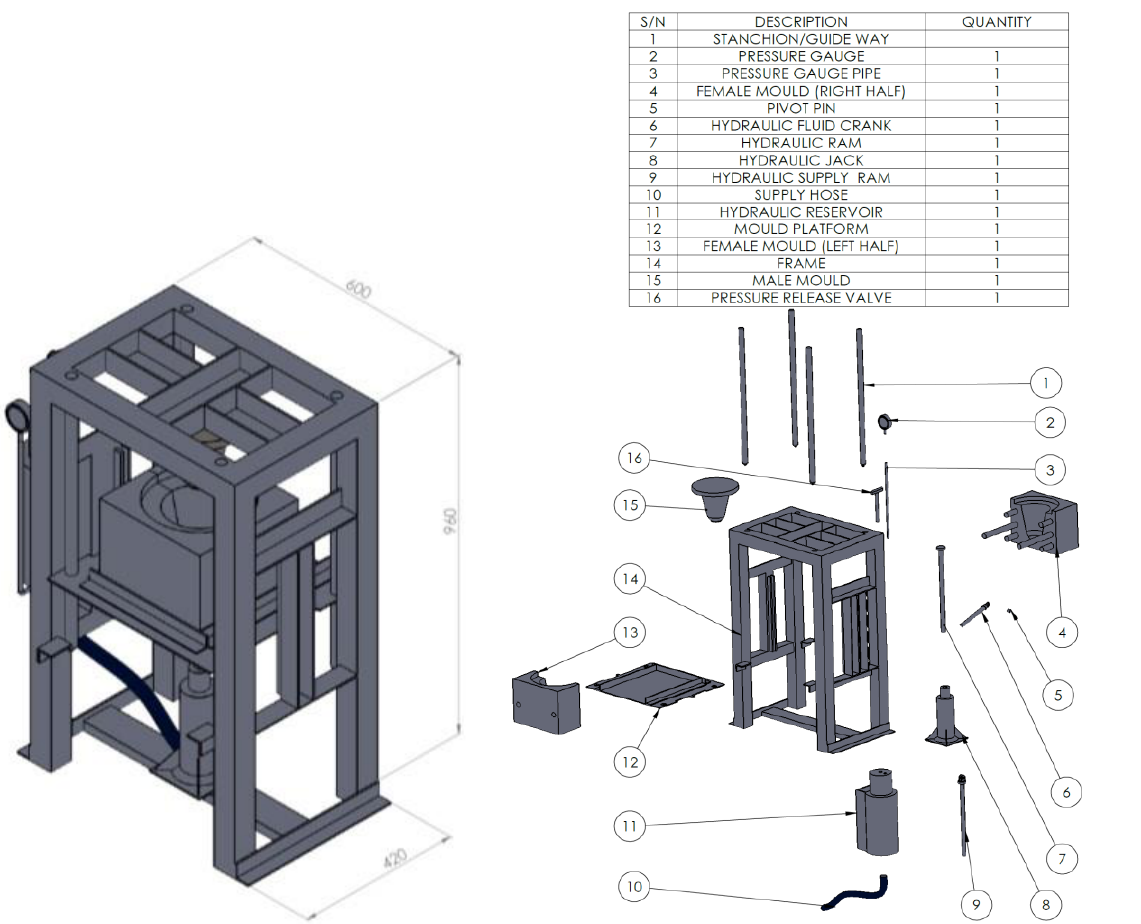
Fig.1. 3D Model of the machine. Fig.2. Exploded drawing of the